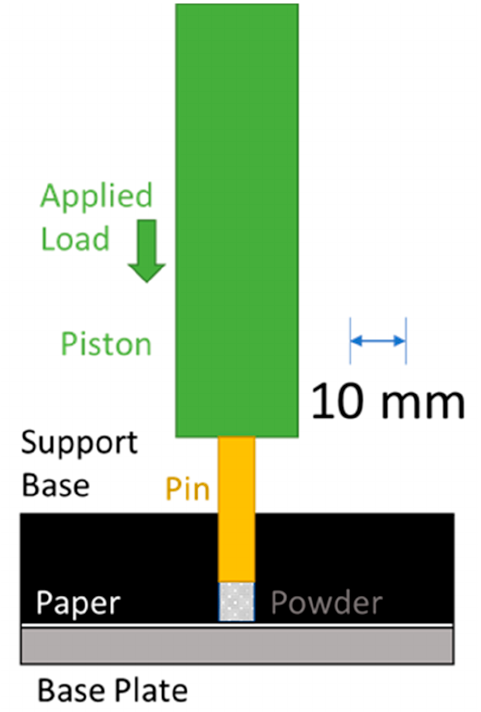
Figure 11. Schematic showing cross section of compactibility test.